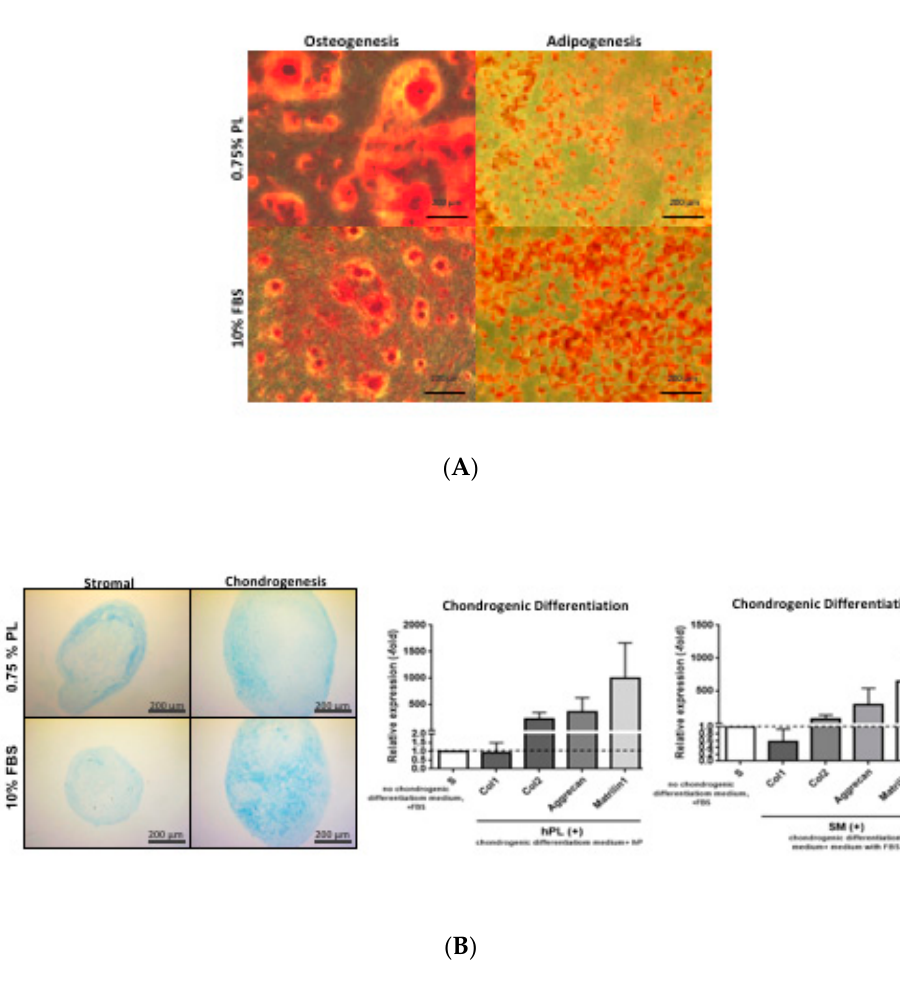
Figure 4. Adipogenic, chondrogenic, and osteogenic differentiation ability of ASCs cultured in 0.75% HPL or 10% FBS containing media. ( A ) Differentiation of ASCs confirmed by staining of two-dimensional cultures with Oil Red O (adipogenesis in the presence of AdipoQual) or Alizarin Red (osteogenesis in the presence of OsteoQual). ( B ) Differentiation of ASCs confirmed by staining with Alcian Blue (chondrogenesis in the presence of ChondroQual vs. StromaQual controls) and by qRT-PCR analysis of the transcribed total RNA for the mRNAs collagen I (Col I), collagen II (Col II), aggrecan, and matrilin 1 (qRT-PCR reactions were conducted in triplicate).